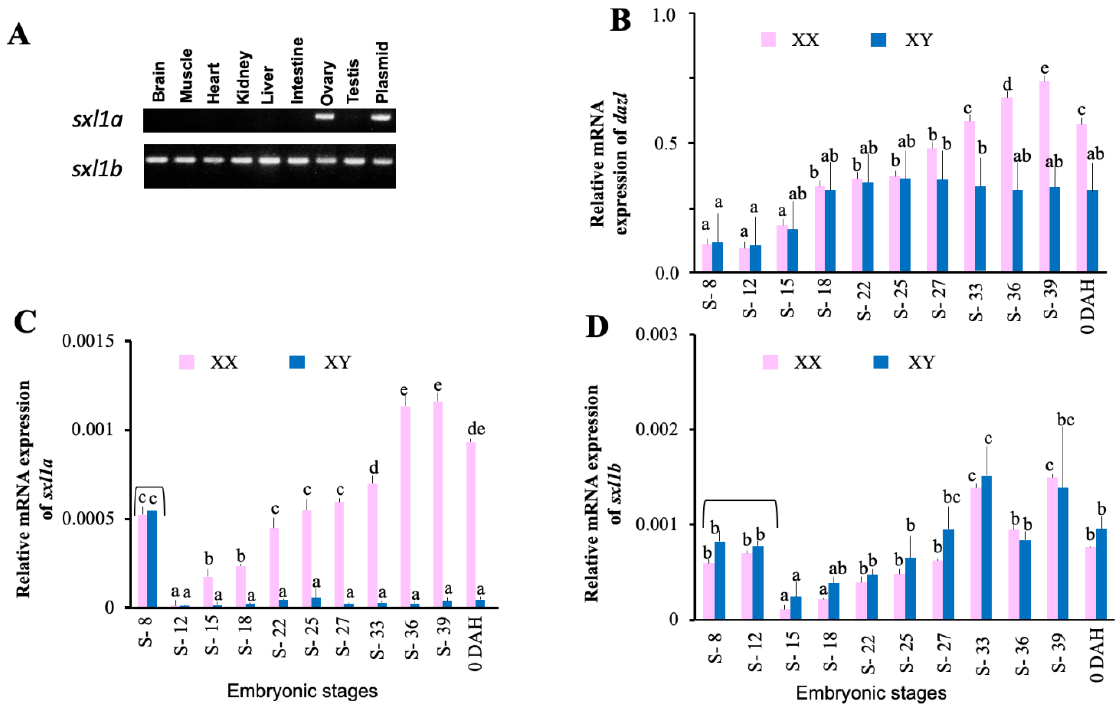
Figure 2. Tissue distribution and mRNA expression analysis of sxl homologue in medaka. Real time PCR analysis of the two isoforms of sxl1 in various tissues of adult medaka ( A ), where B, brain; M, muscle; H, heart; K, kidney; L, liver; I, intestine; O, ovary; T, testis; P, plasmid. Changes in mRNA levels of dazl (germ cell-related gene) ( B ), sxl1a ( C ), and sxl1b ( D ) in XX and XY embryos of medaka collected at stage (S) 8, 12, 15, 18, 22, 25, 27, 33, 36, 39, and 0 DAH. Note: Data are shown as the mean ± SEM and expressed as relative abundance and corrected for the average of ef1 α , β actin , and rps18; different letters denote significant differences at p < 0.05. Black Bracket-Maternal expression.